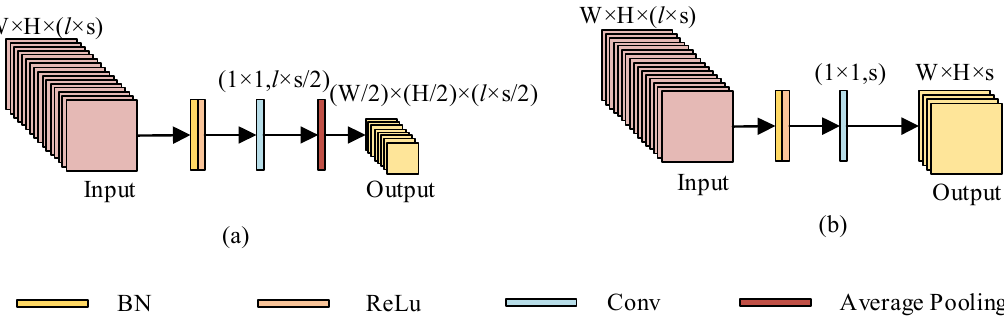
Figure 5. The transition layers: ( a ) the traditional transition layer and ( b ) the improved transition layer.